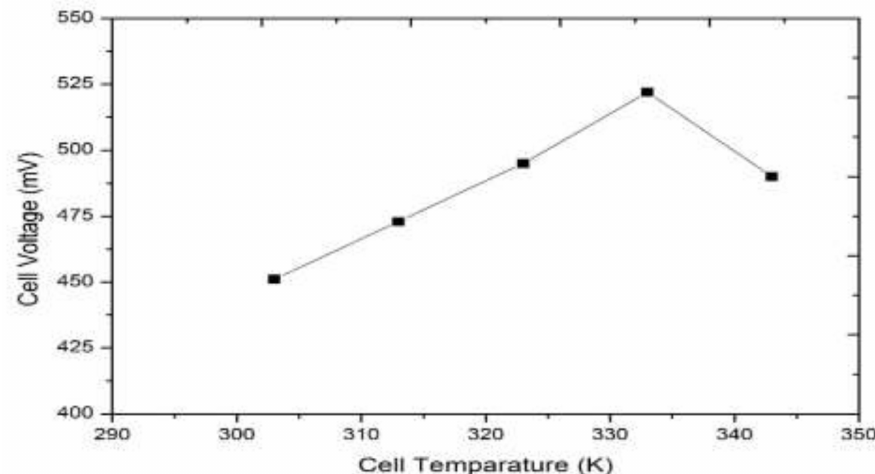
Figure 5. E ff ect of cell temperature.